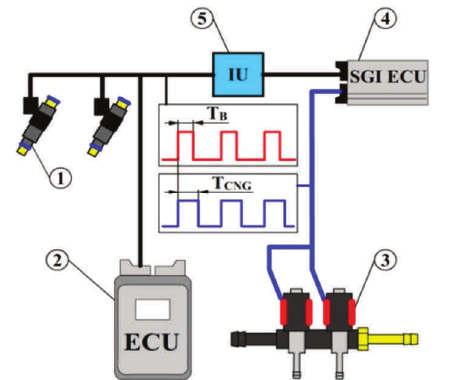
Fig. 1. Scheme of the sequential injector of gas controls [11]: 1 – petrol injector, 2 – engine control unit, 3 – gas injector, 4 – sequential gas injec-